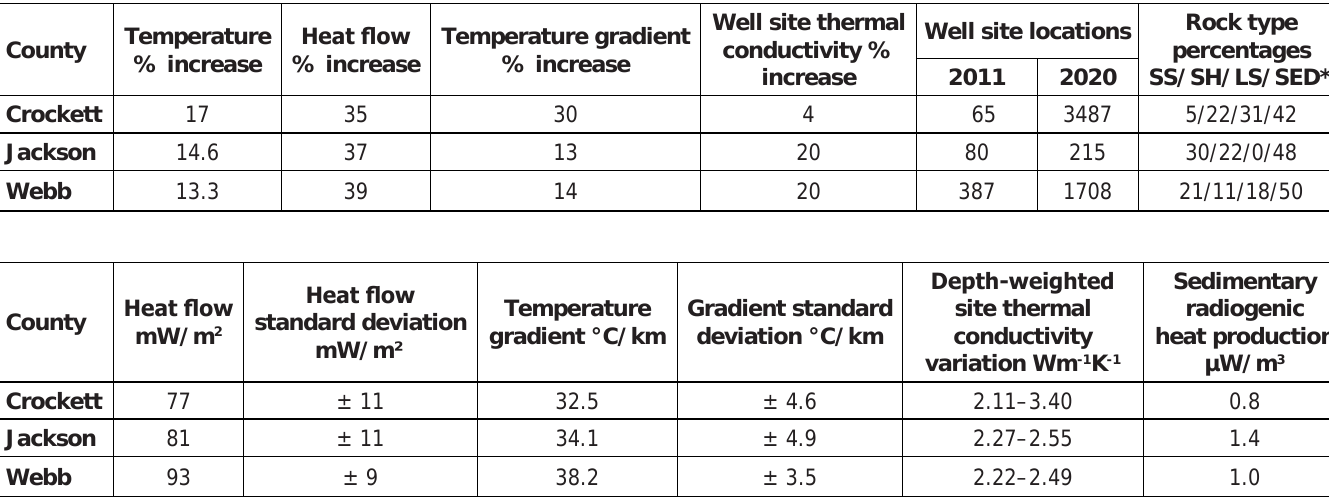
Table 1. The amount of change in county averaged parameters compared to the Blackwell et al. (2011a, 2011b, and 2011c) published results in top chart. Bottom chart are the 2020 average values to show general trends in this research